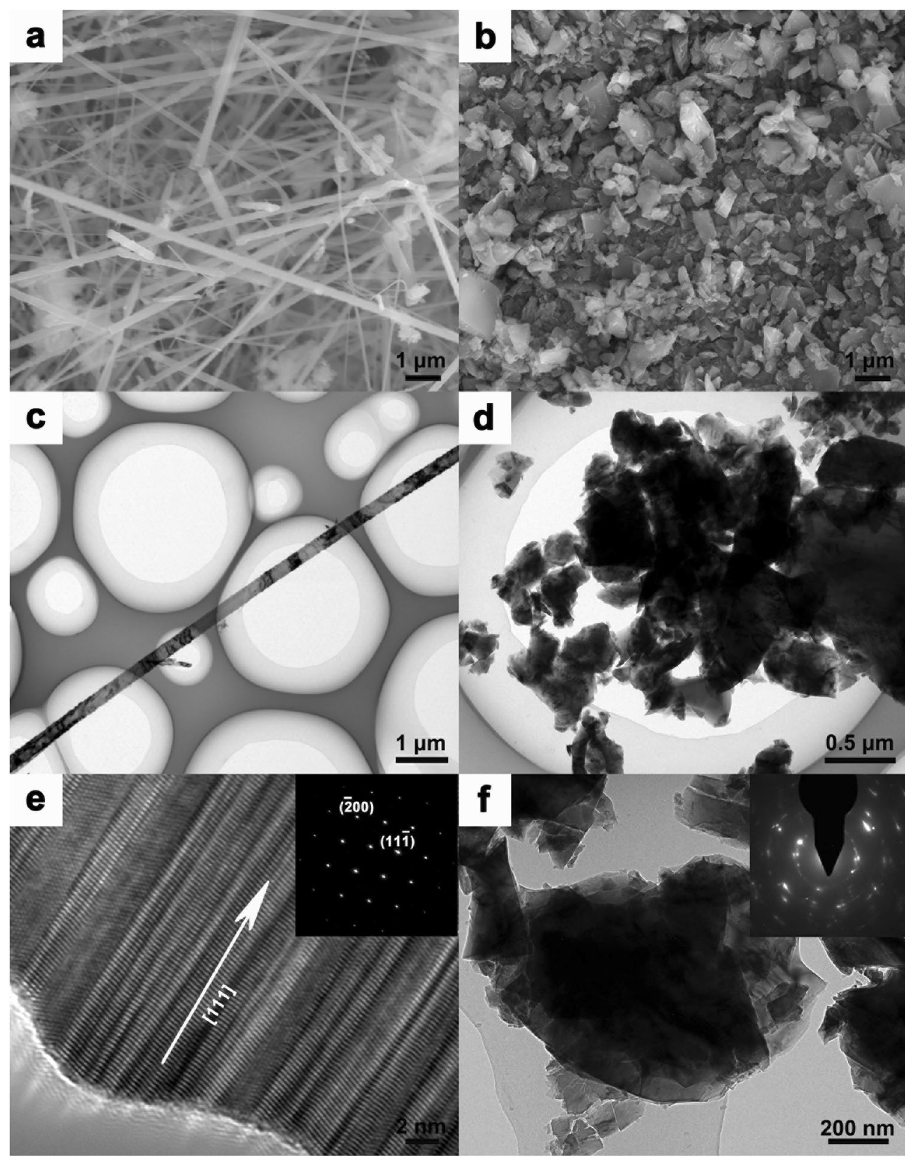
Figure 2. SEM images of ( a ) SiC NWs and ( b ) SiC MPs; TEM images of ( c ) SiC NWs and ( d ) SiC MPs; HR- TEM images of ( e ) SiC NWs and ( f ) SiC MPs. The SAED pattern images of SiC NWs and SiC MPs are show in the inset of ( e ) and ( f